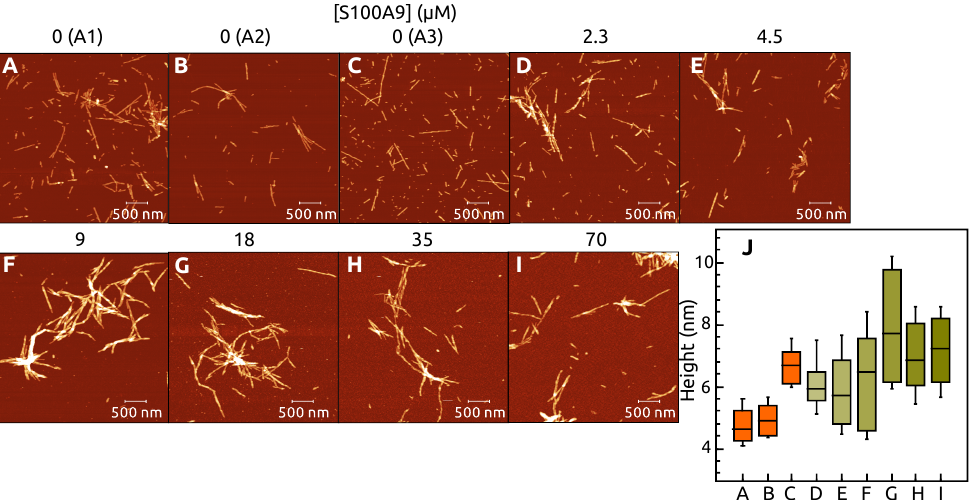
Figure 3. AMF images of α -syn (70µM) aggregated without ( A – C ) or with different concentration of S100A9: 2.3µM ( D ), 4.5µM ( E ), 9µM ( F ), 18µM ( G ), 35µM ( H ) and 70µM ( I ). The cross-section height of fibrils ( J ). The interquartile region (shown by the box), standard deviation (whiskers) and a median (horizontal line inside the box) were calculated from 50